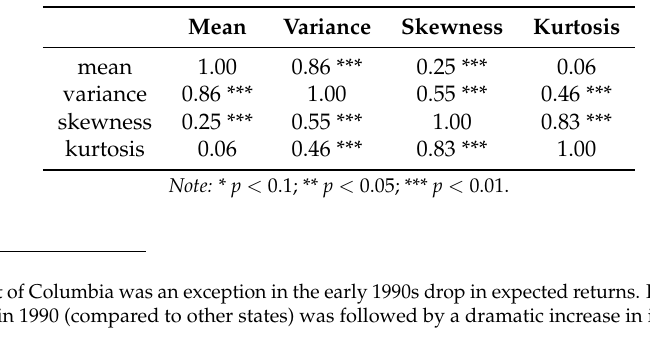
Table 4. Moments correlation